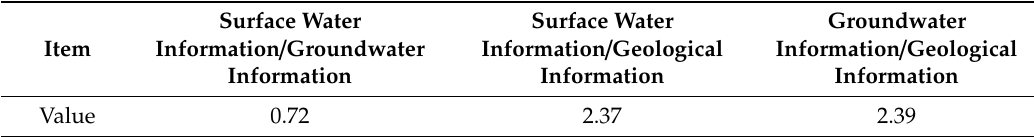
Table 6. Relative values of groundwater information estimated by the AHP with pairwise